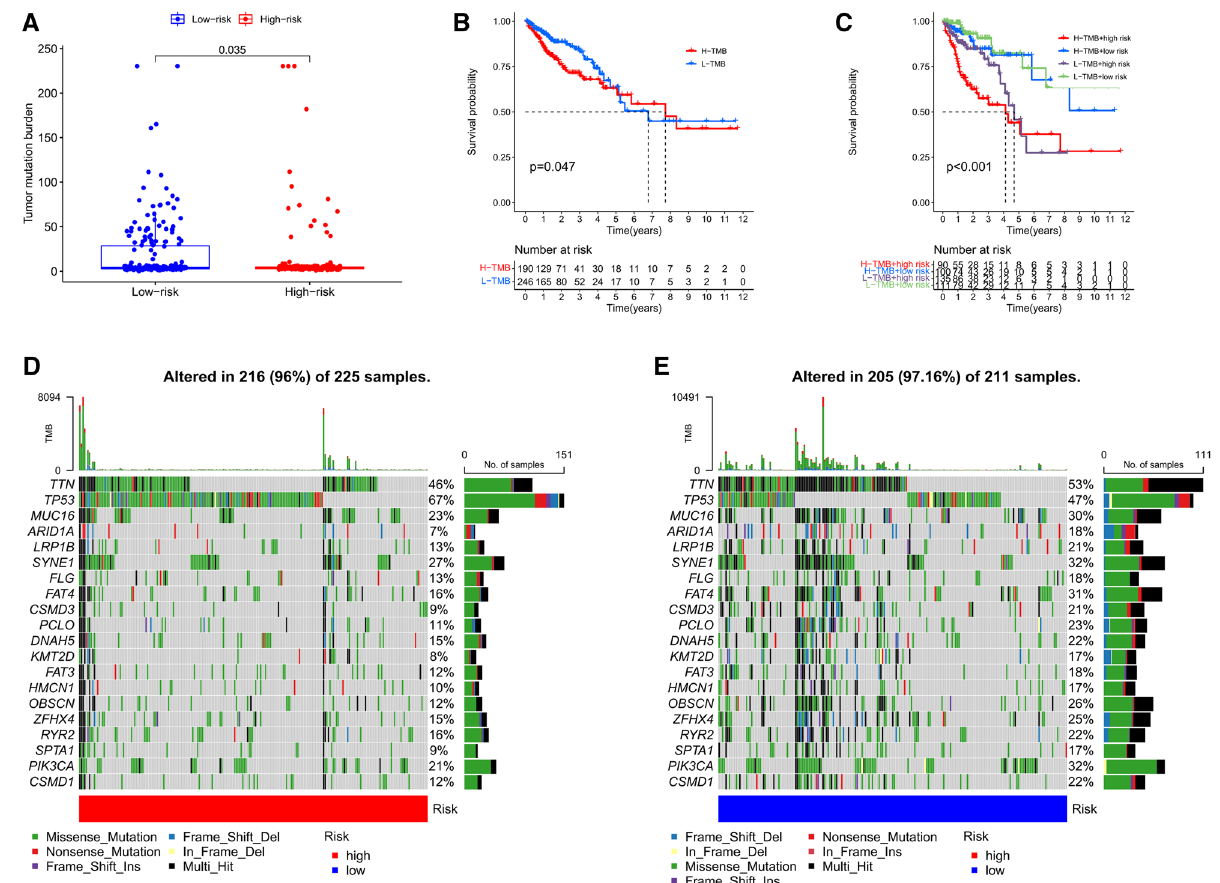
Figure 8. The correlation between the risk signature and TMB. ( A ) The TMB of low-risk group was significantly higher than that of high-risk group. ( B ) Kaplan–Meier curves of overall survival in different TMB subgroups. ( C ) Kaplan–Meier curves of overall survival stratified by both TMB and risk score. The waterfall diagram showed the top 20 driver genes exhibiting the highest mutation frequency in ( D ) high- and ( E ) low-risk